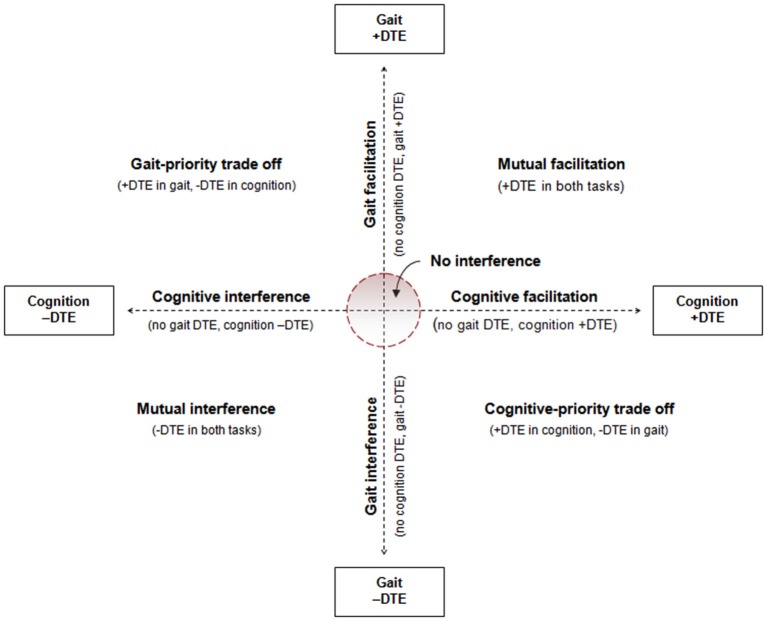
Illustration of conceptual model for characterizing patterns of cognitive-motor dual-task interference. Figure is from Plummer et al. (2014), and adapted from conceptual framework of Plummer et al. (2013).